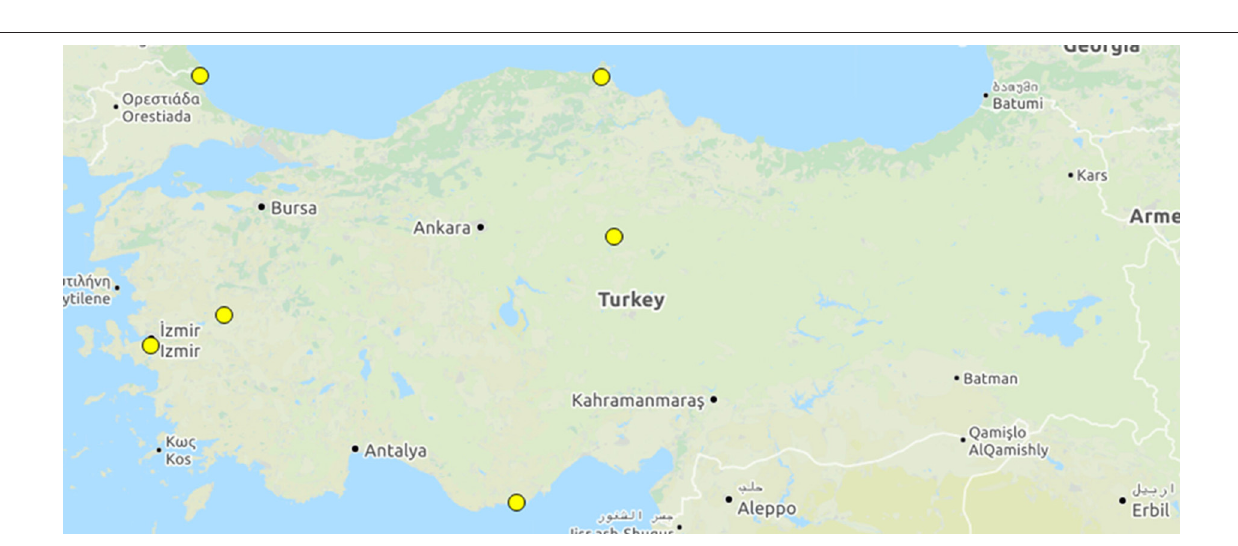
FIGURE 11 | Environmental conflicts against nuclear energy, Turkish Map of Environmental Justice, March 2017